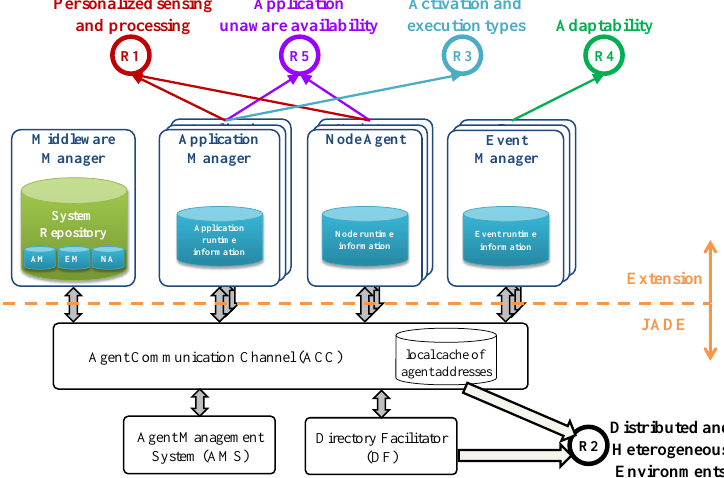
Figure 5. Architecture of the multi-agent based middleware.